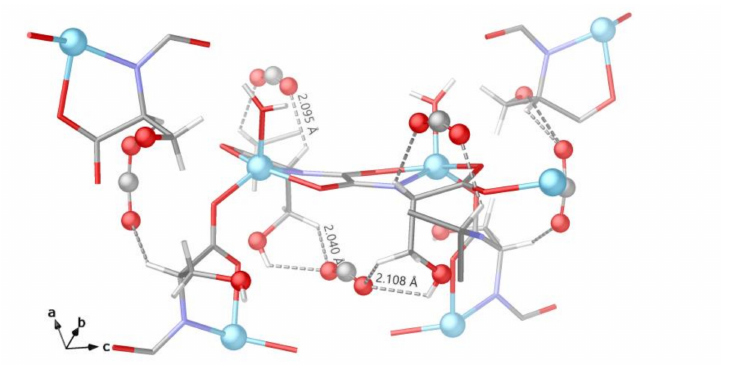
Figure 4. Details of CO 2 @1 crystal structure showing the adsorption sites identified for CO 2 adsorbed molecules. Color code as in Figure